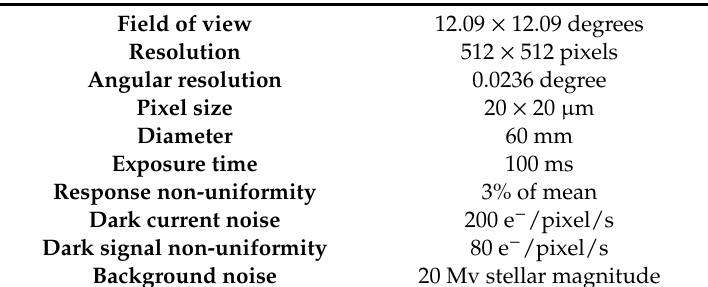
Table 4. Simulation parameters for a dynamic condition.